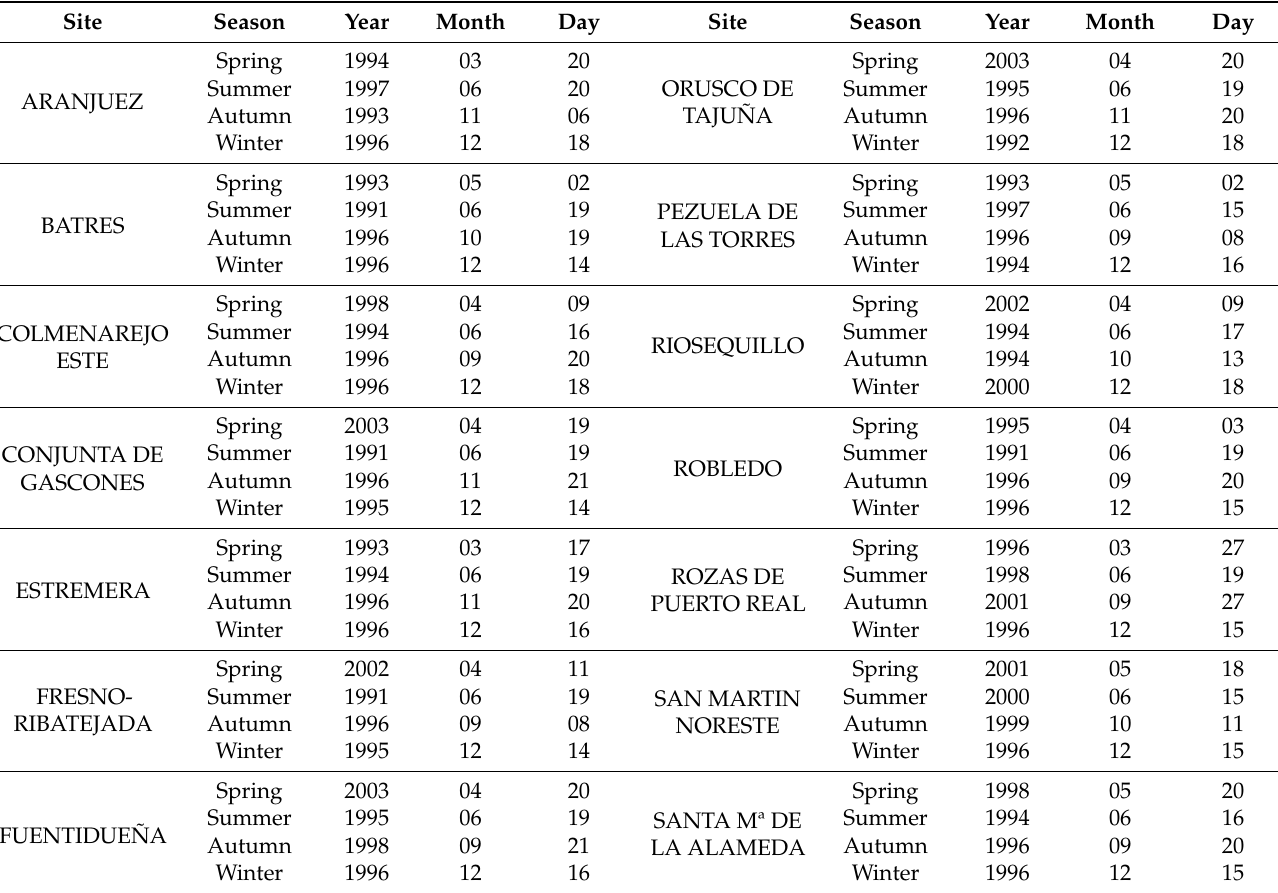
Table A2. First day of the Typical Meteorological Week of each season for each of the EDAR